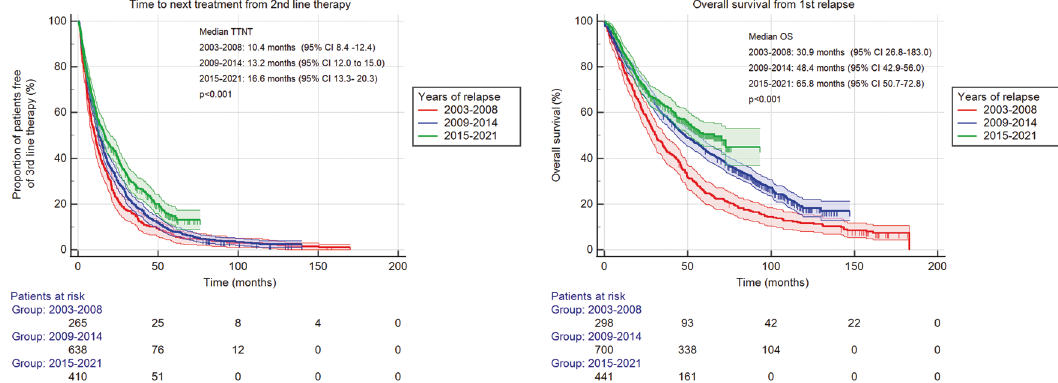
Fig. 3 Time to next treatment (TTNT) and overall survival (OS) from fi rst relapse estimates in 1439 treated patients with multiple myeloma strati fi ed by the year of initiation of second-line therapy. CI con fi dence interval.